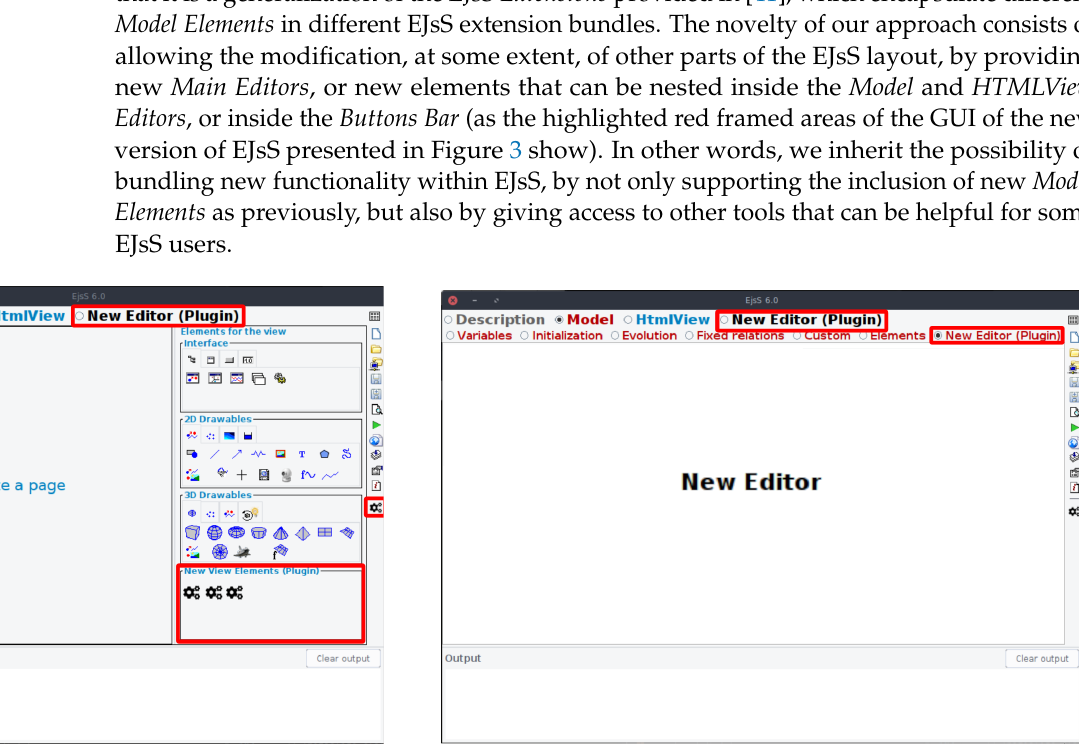
Figure 3. Customizing options of EJsS GUI and functionality with Extension